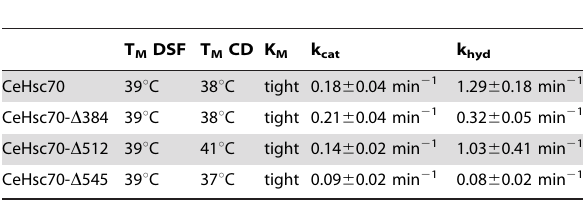
Table 1. Biophysical and enzymatic characterization of lid domain